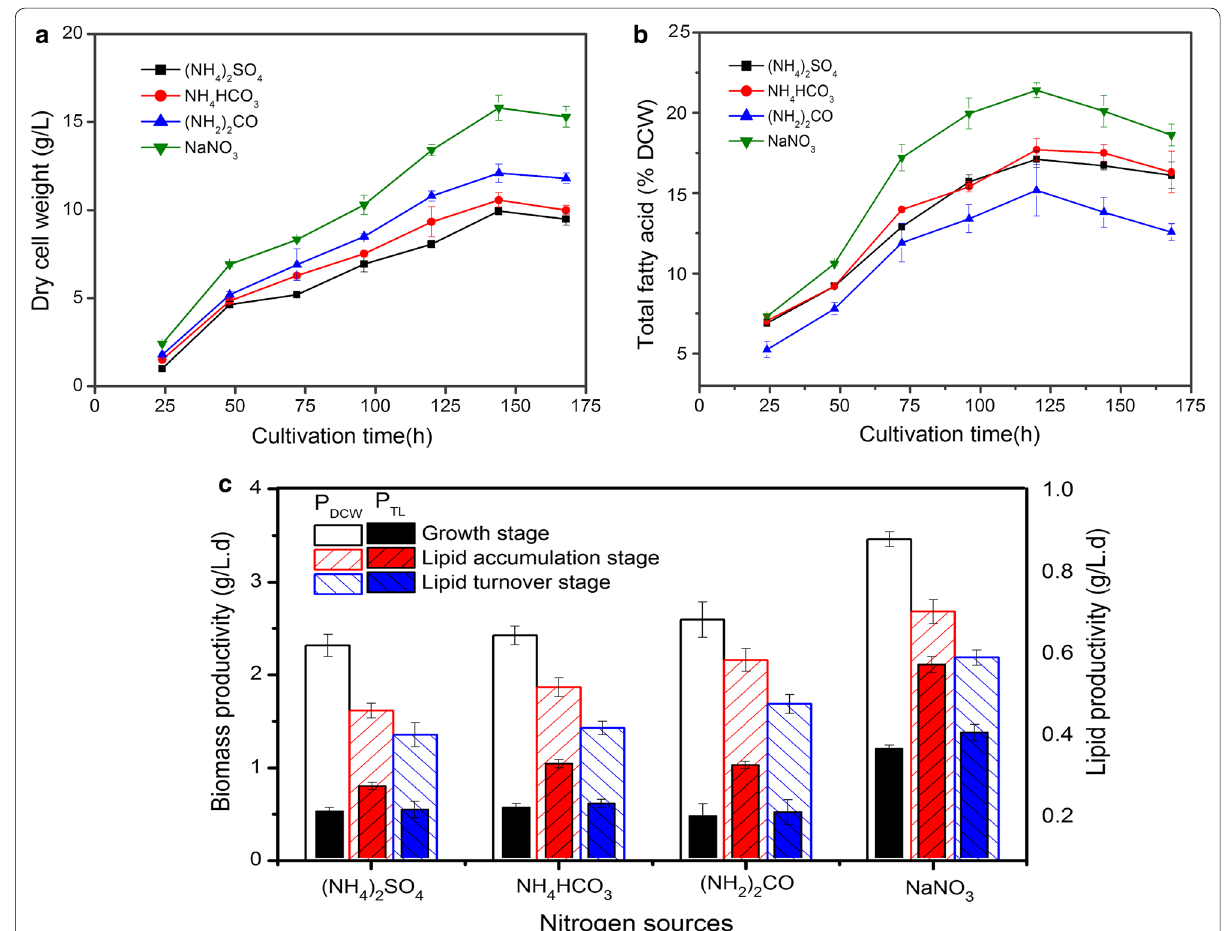
Fig. 1 The time-course profile of cell growth and lipid accumulation in C. Cohnii under different N-sources. a Dry cell weight (DCW, g/L), b total fatty acid (TFA, % DCW) of C. cohnii for cultured for 7 days. c Biomass productivity (P DCW , g/L day) and lipid productivity (P TL , g/L day) of C. Cohnii grown on different N-sources at three different growth stages. All experiments were performed in triplicate. The data presented here is